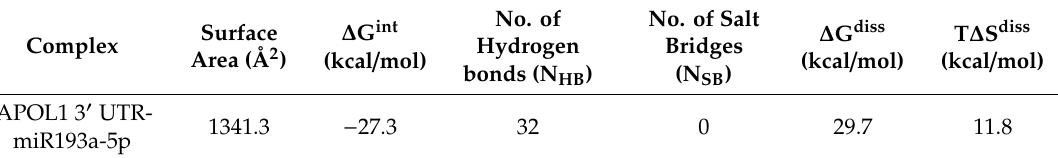
Table 4. APOL1 3 (cid:48) UTR-miR193a-5p